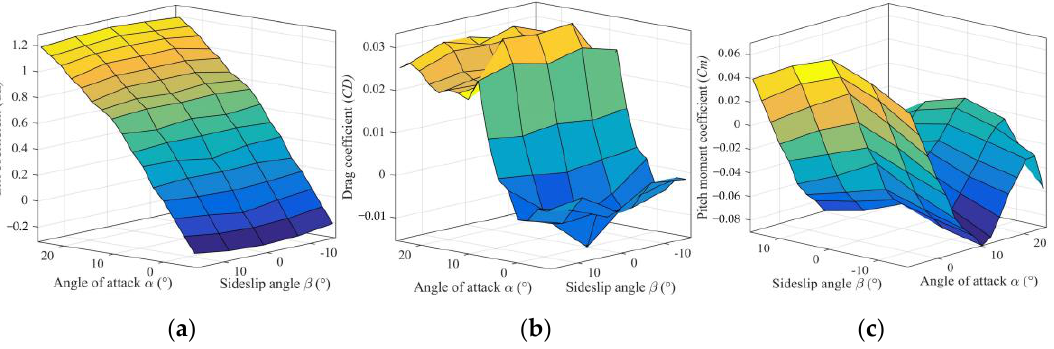
Figure 8. Force measurement data from traditional wind tunnel tests ( V = 30 m/s): ( a ) lift coefficient; ( b ) drag coefficient; ( c ) pitch moment coefficient.